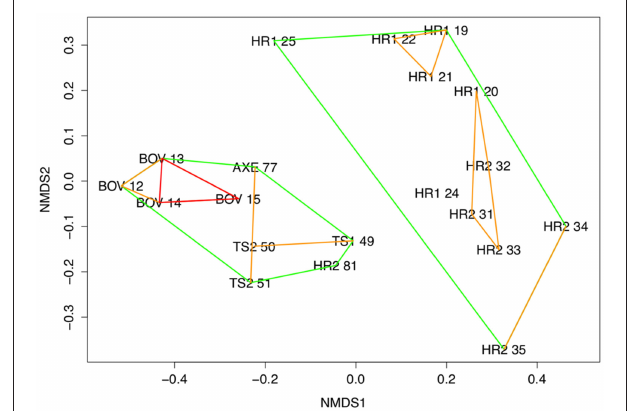
FIGURE 2 | Multidimensional scaling ordination with ordinal hulls. Ordinal hulls based on Manhattan distance computed during cluster analysis. Hulls indicate areas of < 0.7 dissimilarity (green), < 0.5 (blue), and < 0.3 (red). 2-D stress = 0.13. Site numbers refer to deployments ( Table 1 ), using whole core data.